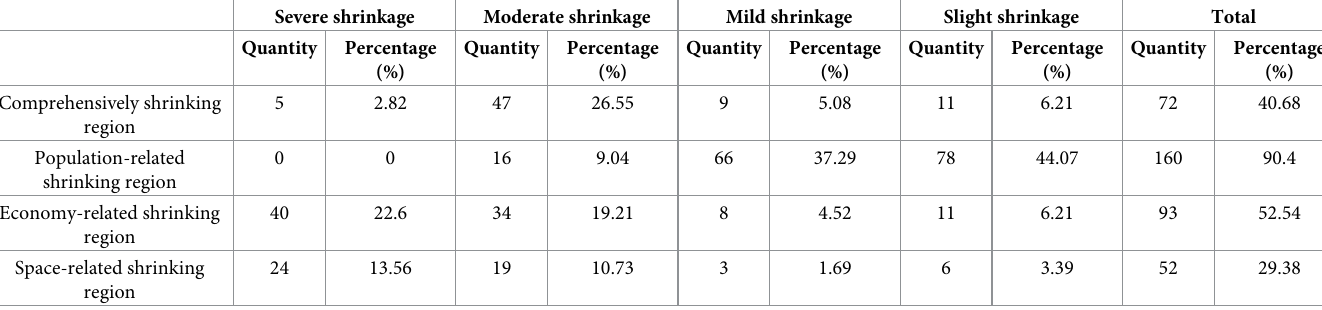
Table 2. Hierarchical statistics of regional shrinkage of the three northeastern provinces from 2012 to 2018.